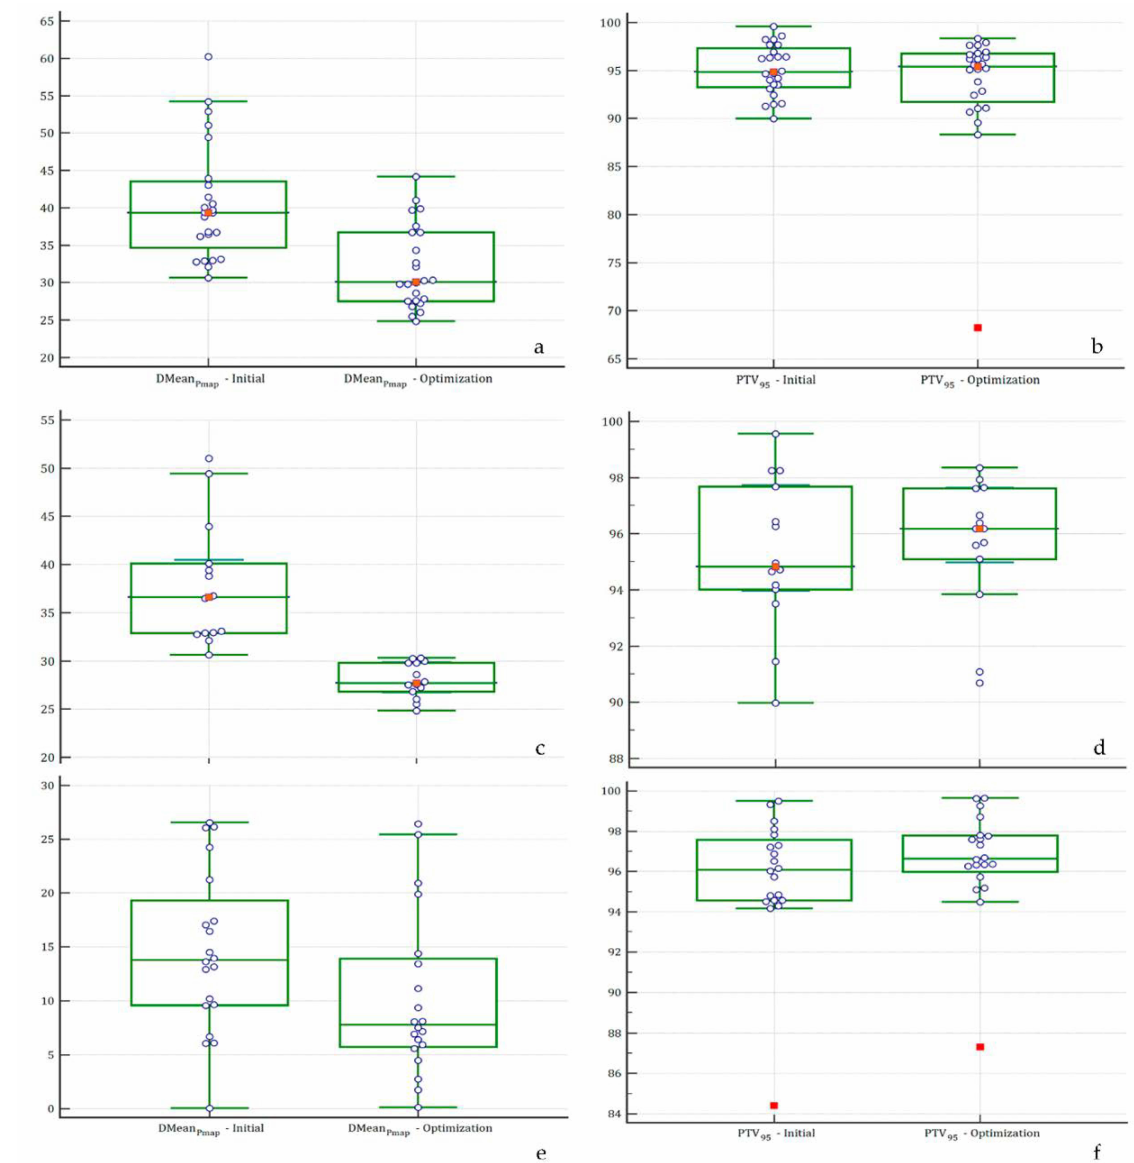
Figure 2. Changes in the DMean Pmap and PTV coverage across each cohort; ( Y -axis: percentage of coverage by the 95% isodose). DMean Pmap ( a ) and PTV coverage ( b ) across Cohorts 1 + 2. The DMean Pmap ( c ) and PTV coverage ( d ) across Cohort 1. The DMean Pmap ( e ) and PTV coverage ( f ) across Cohort 3. Abbreviations: DMean Pmap : mean dose received by the Pmap region, PTV 95 : percentage of the Planning Target Volume (PTV) covered by 95% of the prescribed